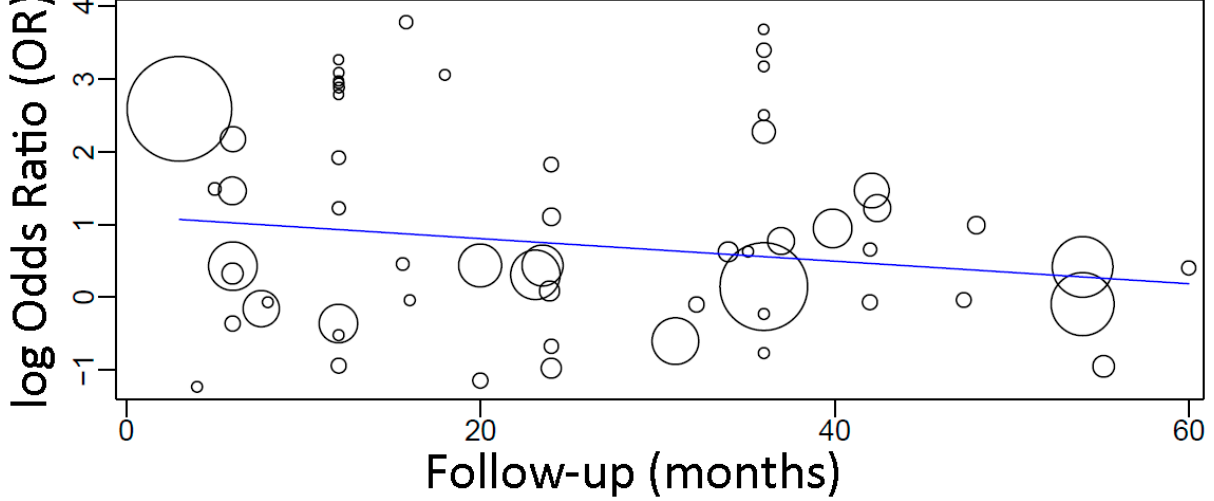
Figure 8. Scatter plot for the meta-regression with the association between the odds ratio (OR) of implant failure between diabetic and non-diabetic individuals, and the follow-up time (in months; limited to 60 months). Every circle represents a study and the size of the circle represents the weight of the study in the analysis.